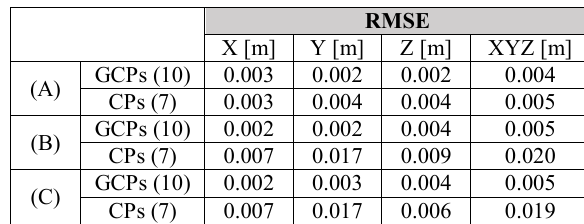
Table 5 . Mean errors on GCPs and CPs (school datasets). (A) Visible dataset; (B) thermal dataset (Workflow 1); (C) thermal Figure 10 . Dense point cloud of the parabolic arch derived from dataset (Workflow 2). the thermal dataset (processed according to the Workflow